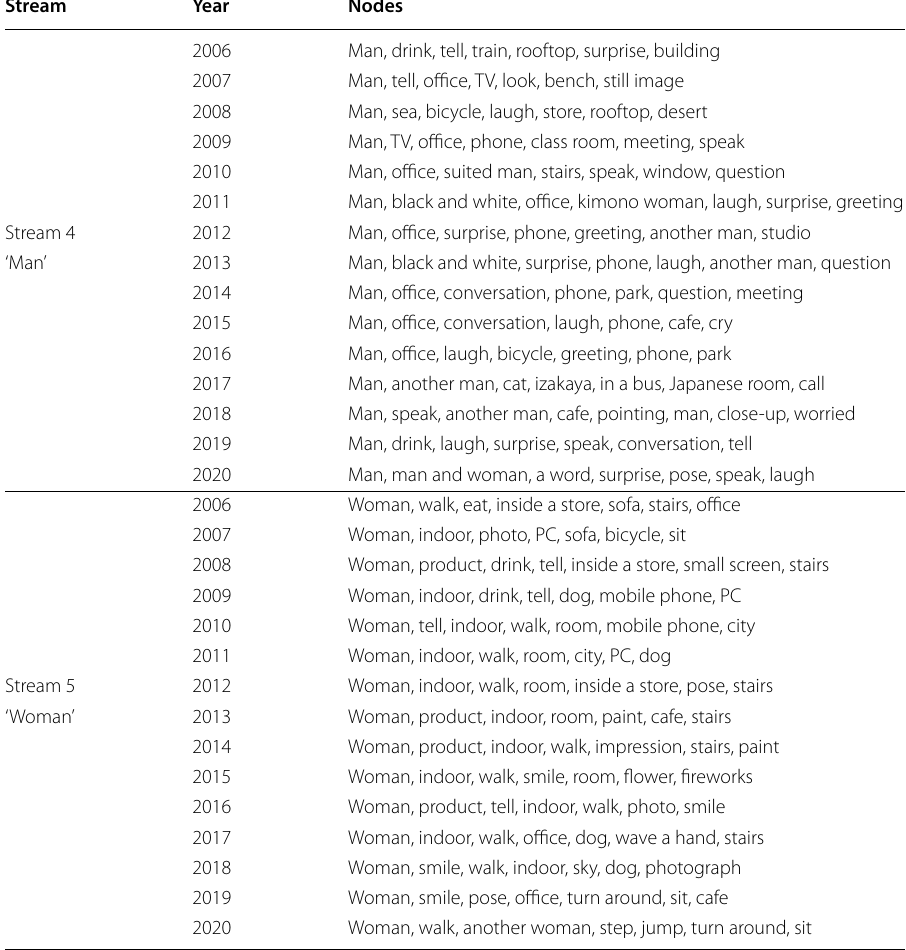
Table 6 Seven nodes with the largest strength in each community involved in Streams 4 and 5